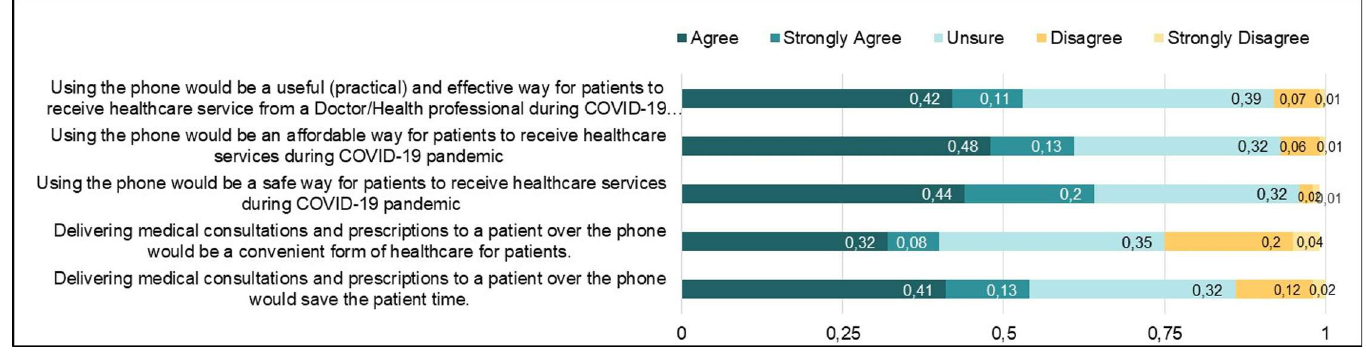
Fig 2. Perception on the benefits of telemedicine among healthcare